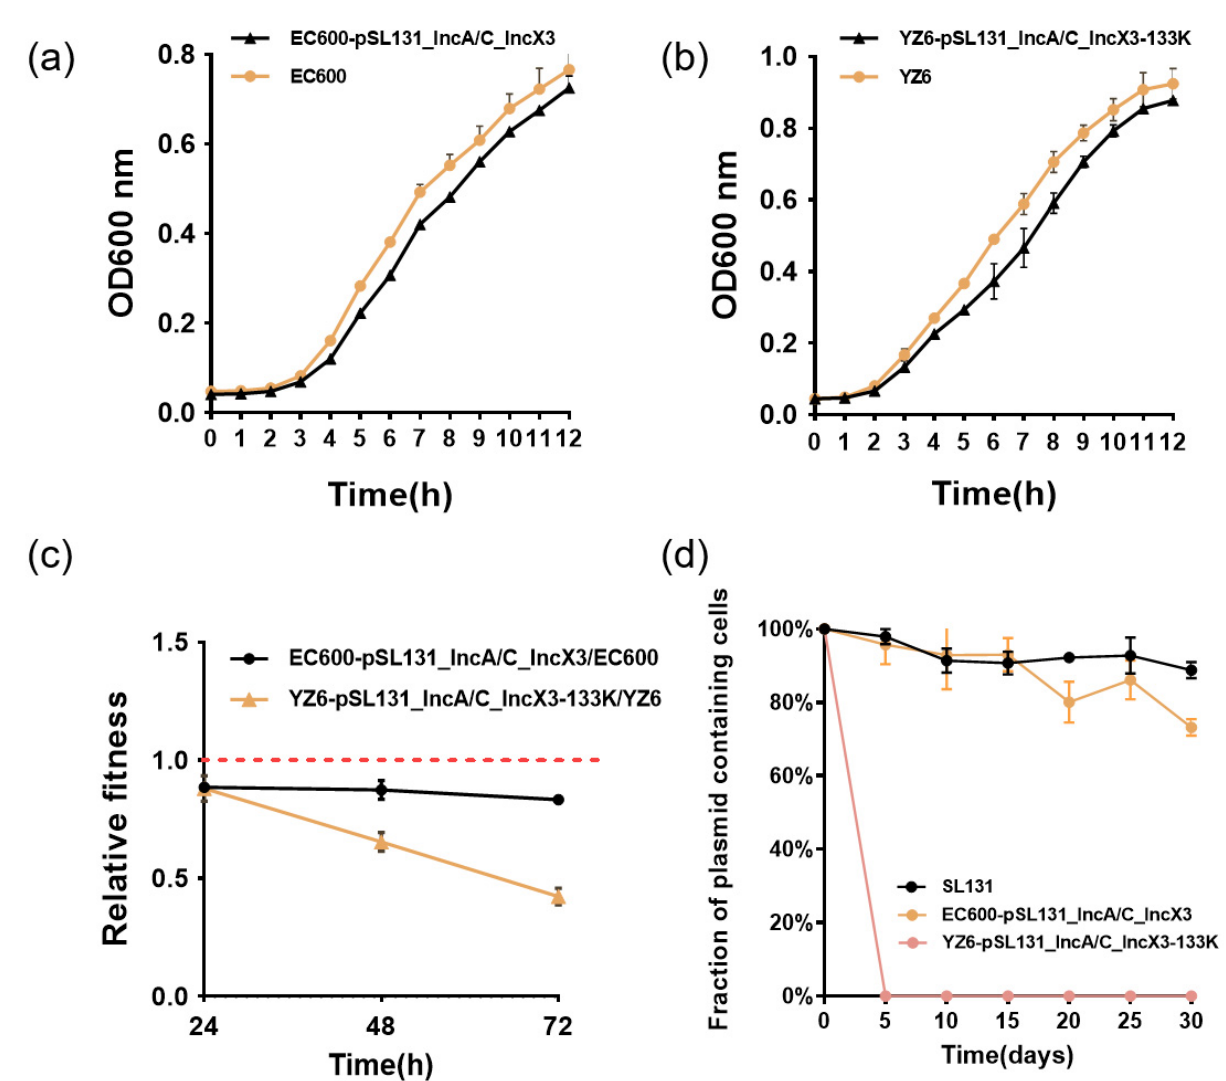
Figure 4. Initial fitness cost after acquisition of cointegrate plasmid in EC600 and YZ6 strains and plasmid persistence results of SL131, EC600-pSL131_IncA/C_IncX3, and YZ6-pSL131_IncA/C_IncX3-133K. ( a , b ) Growth curves of EC600 and EC600-pSL131_IncA/C_IncX3, YZ6 and YZ6-pSL131-IncA/C-IncX3-133K. ( c ) Relative fitness of two pSL131_IncA/C_IncX3 carrying strains. Relative fitness value less than 1 indicates fitness defect, and a value greater than 1 indicates fitness benefit. ( d ) Plasmid stability in bacterial population after serial passaging in antibiotic-free medium. Each point is the mean of three individual replicates, and error bars show standard deviation.